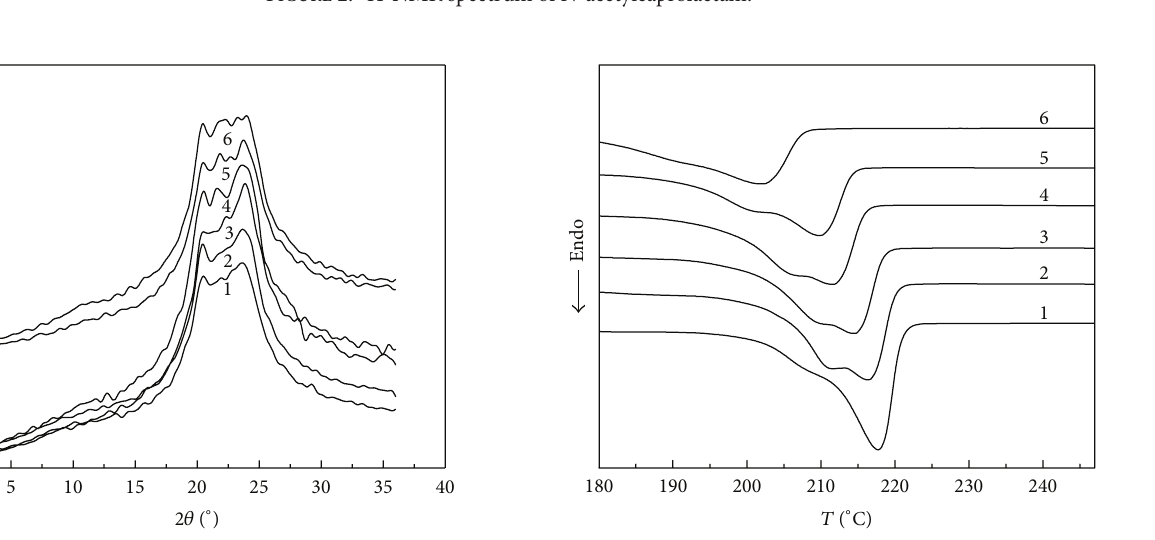
Figure 3: Wide angle X-ray diffraction patterns of LiCl/PA6 com- posites with different LiCl content: (1) 0.0%; (2) 0.1%; (3) 0.3%; (4) 0.5%; (5) 1.0%; (6) 2.0%.